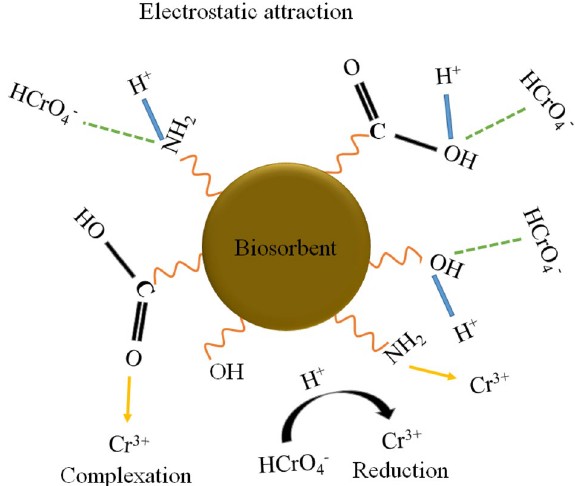
Figure 6. The mechanism for adsorption of Cr(VI) on